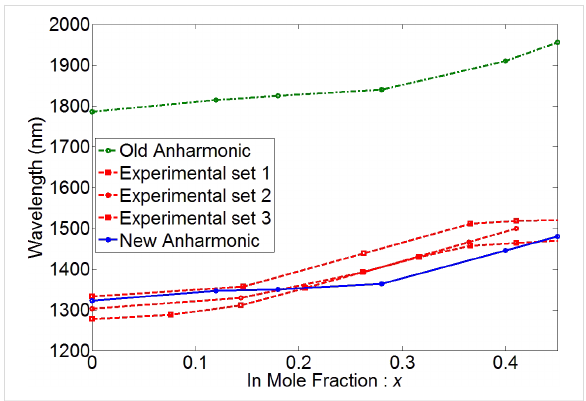
Figure 10: Experimental and simulation results of the optical transition of the QD system reported in [9]. Increasing the In mole fraction in- creases the transition wavelength. The optimization of the anharmonic strain model has greatly improved the simulation results.